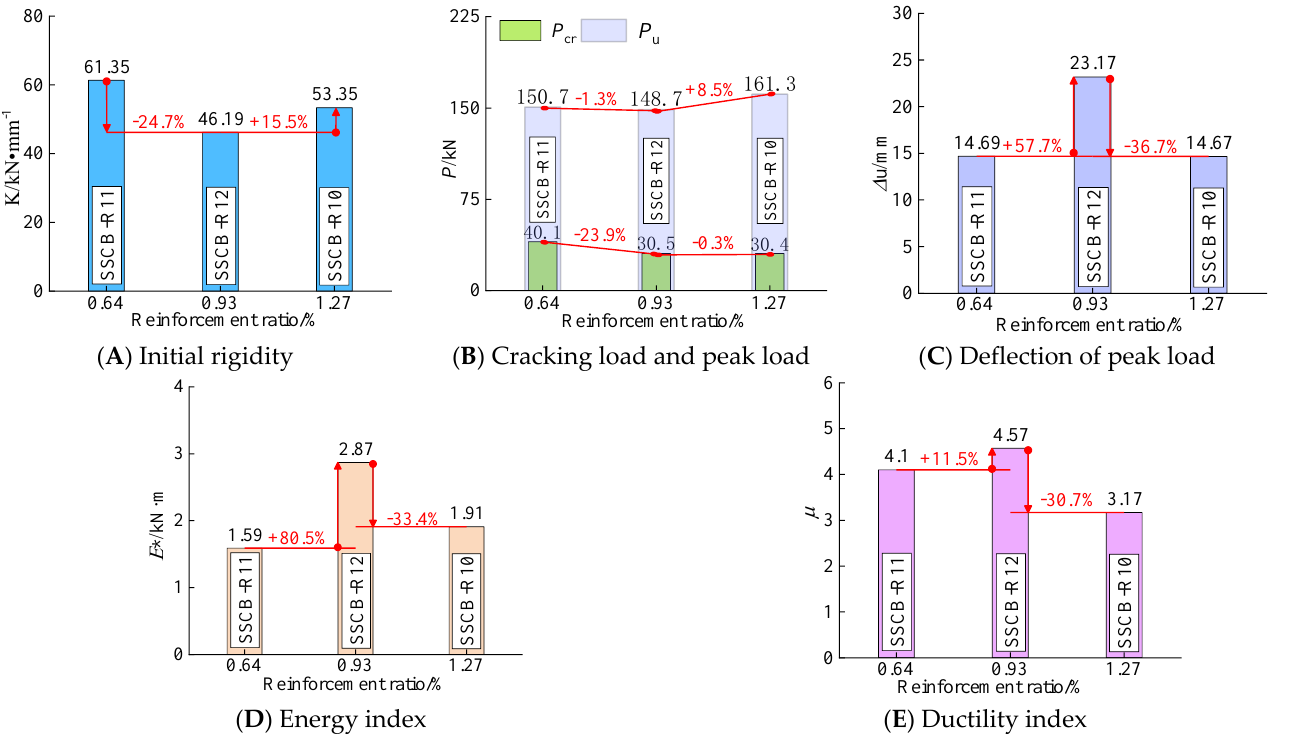
Figure 9. The performance index changes with the ratio of reinforcement.